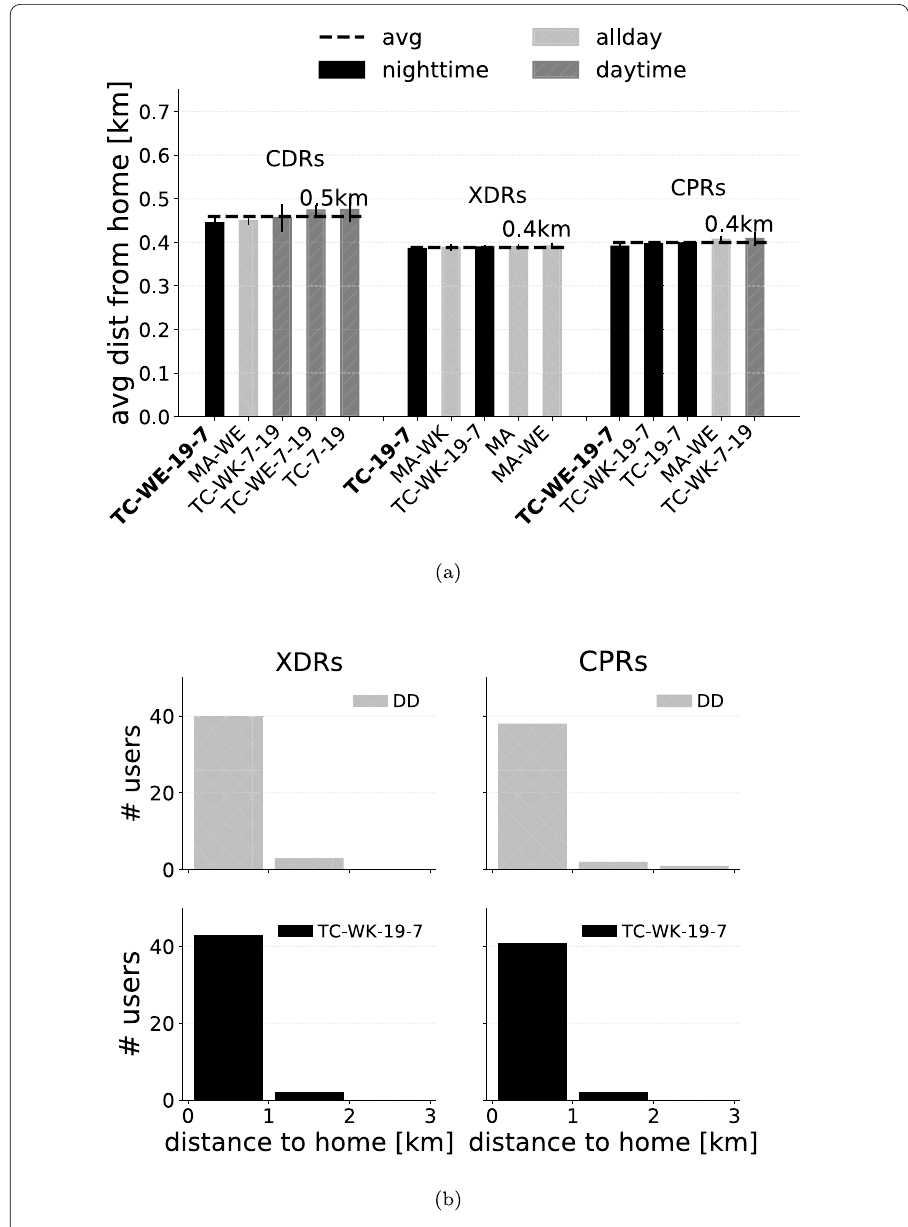
Figure 8 ( a ) Average distance between the home location detected by each HDA ( k = 1, any of the three closest towers) on each stream and the actual user’s home location considering only those users for which the home is correctly detected. ( b ) Distribution of the distances to the actual home for DD and TC-WK-19-7 on XDRs and CPRs, considering only those users for which the home is correctly detected